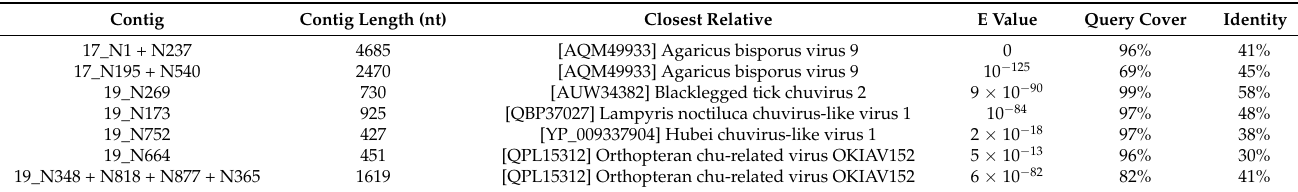
Table 2. Virus-related contigs that are not likely to be complete virus